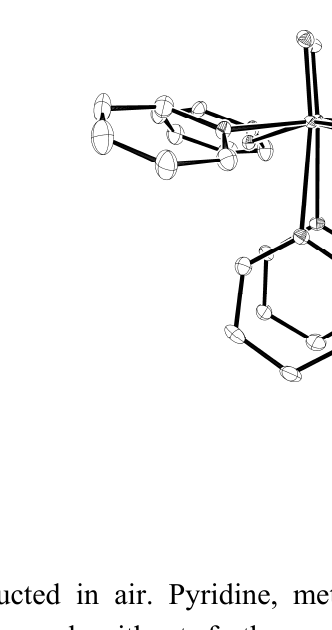
Figure 2. A view along the metal − metal bond